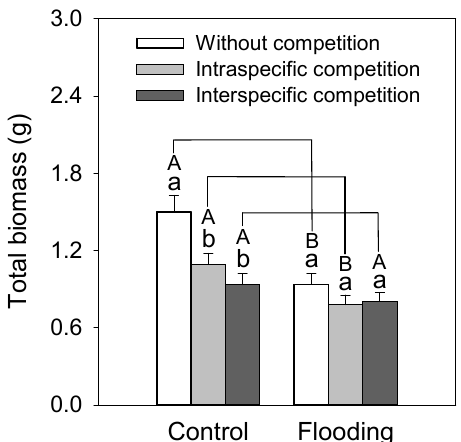
Figure 4. Total biomass of P. hydropiper under control and flooding treatments without competition, with intraspecific competition, or with interspecific competition. Data are mean values (+s.e., n = 6). Different lowercase letters indicate significant differences among treatments in control or flooding conditions, whereas different uppercase letters indicate significant differences between control and flooding treatments with different competition types ( p < 0.05).